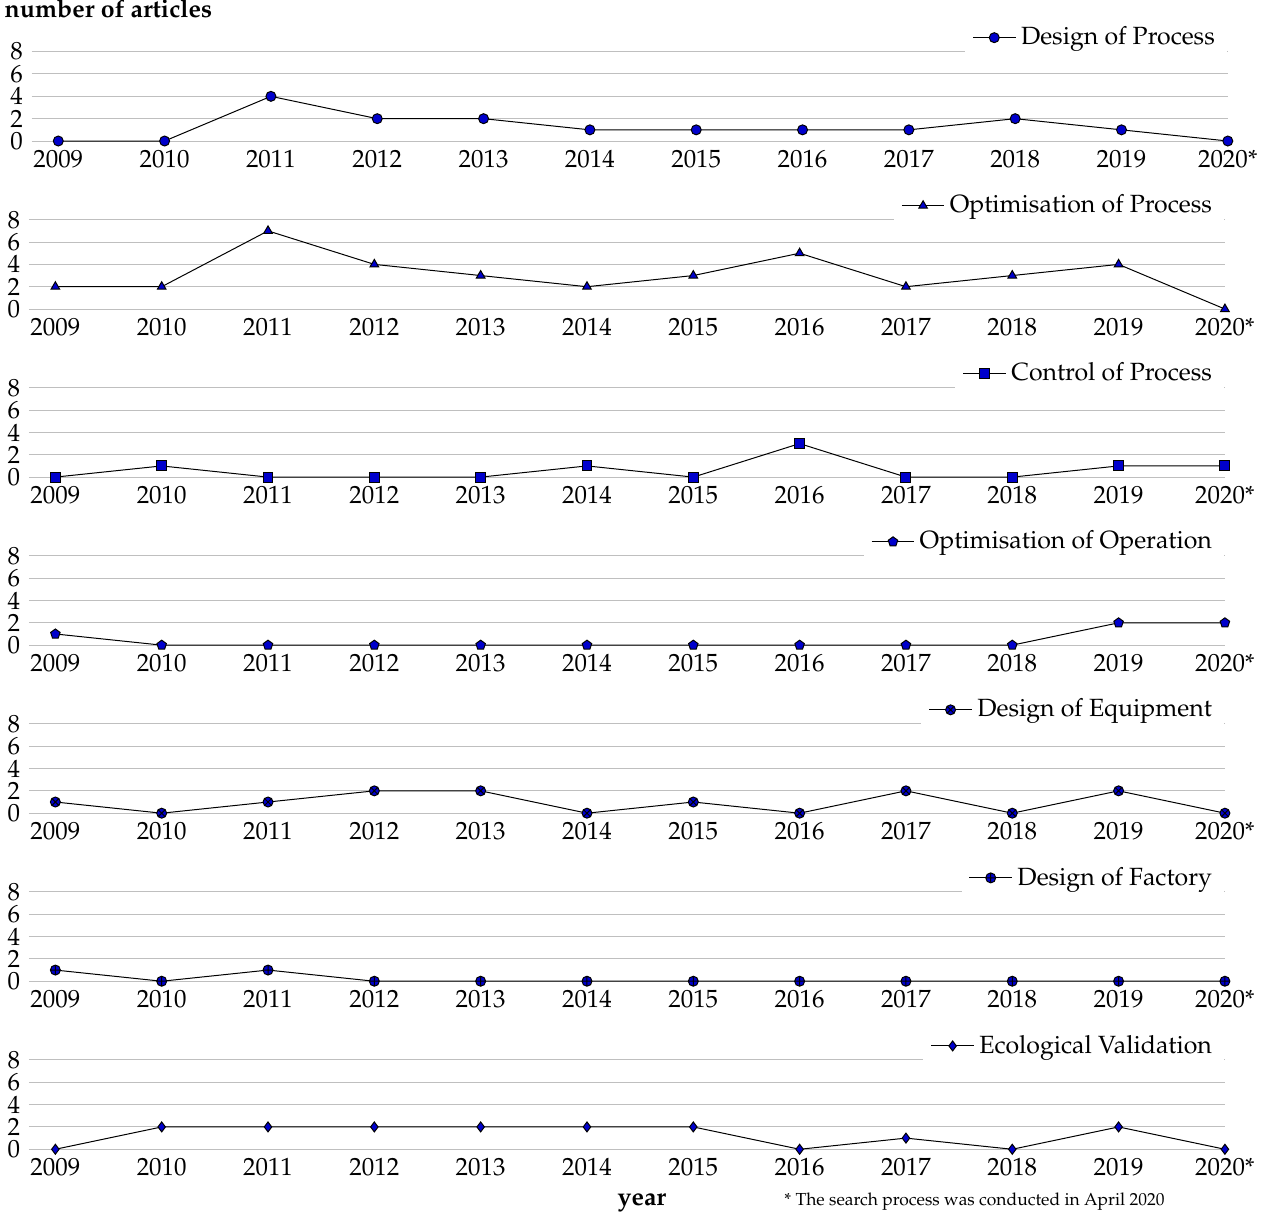
Figure 9. Number of articles over time for the category Purpose of